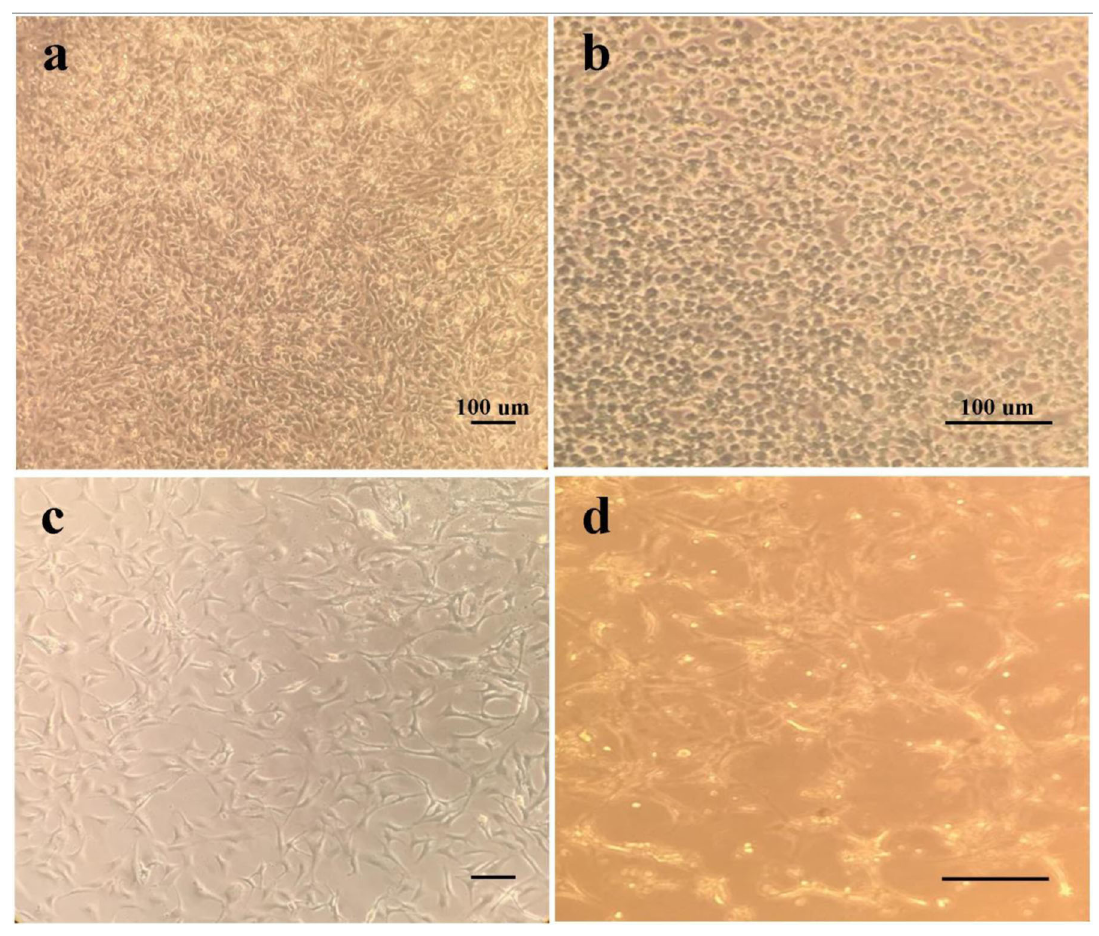
Fig. 4 The cell morphology of TCPS ( a ), the cell morphology after the treatment with 2 µl ( b ), the cell morphology after the treatment with 7 µl ( c ) and the cell morphology after the treatment with 12 µl ( d ) of the batch curcumin niosome nanoparticles. Approximately, the cells are intact in ( a – b ) groups, while the cells of ( c – d ) con fi rm the